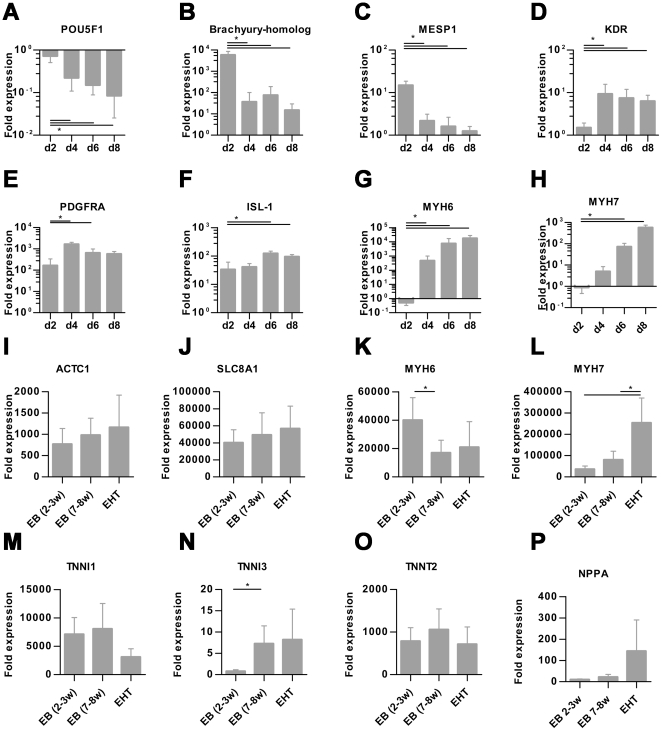
Transcript analysis.A–H: Quantitative RT-PCR analysis of stemness marker (POU5F1, POU class 5 homeobox 1), mesodermal marker (brachyury homolog, MESP1, mesoderm posterior 1 homolog, KDR, vascular endothelial growth factor receptor 2, PDGFRA, platelet derived growth factor receptor alpha) and cardiac marker (ISL1, Islet-1, MYH6, α-myosin heavy chain, MYH7, ß-myosin heavy chain,) in EB-based cardiac differentiation on day 2, 4, 6, and 8, normalized to undifferentiated hESCs. For these experiments Stage 1 duration (mesodermal induction) was set to 24 hours, 4–7 biological replicas. I–L: Quantitative RT-PCR analysis of alpha actin (ACTC1), sodium/calcium exchanger (SLC8A1), MYH6 and MYH7 in EBs (2–3 weeks old), EBs (7–8 weeks old) and EHTs (5 weeks old) normalized to undifferentiated hESC, 4–6 biological replica. Bars show mean ± SD, *P<0.05 (Student's t-test), bars show means ± SD.